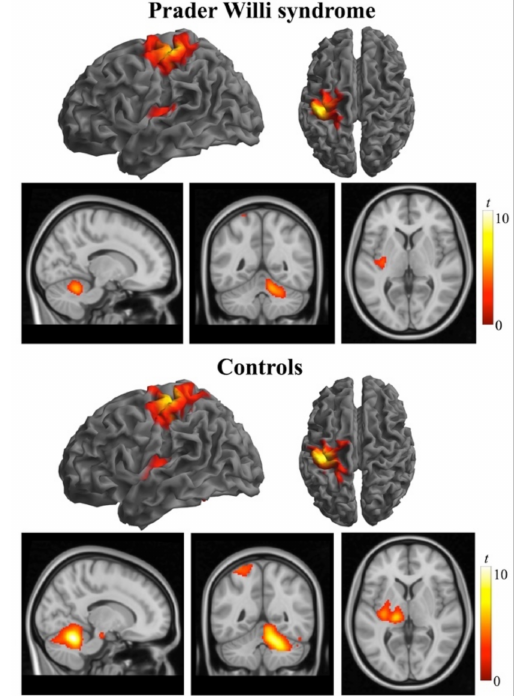
Figure 1. Brain activation (one sample t -tests) obtained during the flexion-extension task with the right hand in individuals with Prader Willi syndrome (top rows) and control subjects (bottom rows). For each group, the functional data are displayed on the lateral and dorsal cortical surfaces (white background) and superimposed on a high-resolution anatomical template (sagittal, coronal, and axial views, respectively; black background) using SPM. Activations are thresholded at p FWE - corrected < 0.05. Color bars represent t values. Right in axial and coronal views corresponds to the right